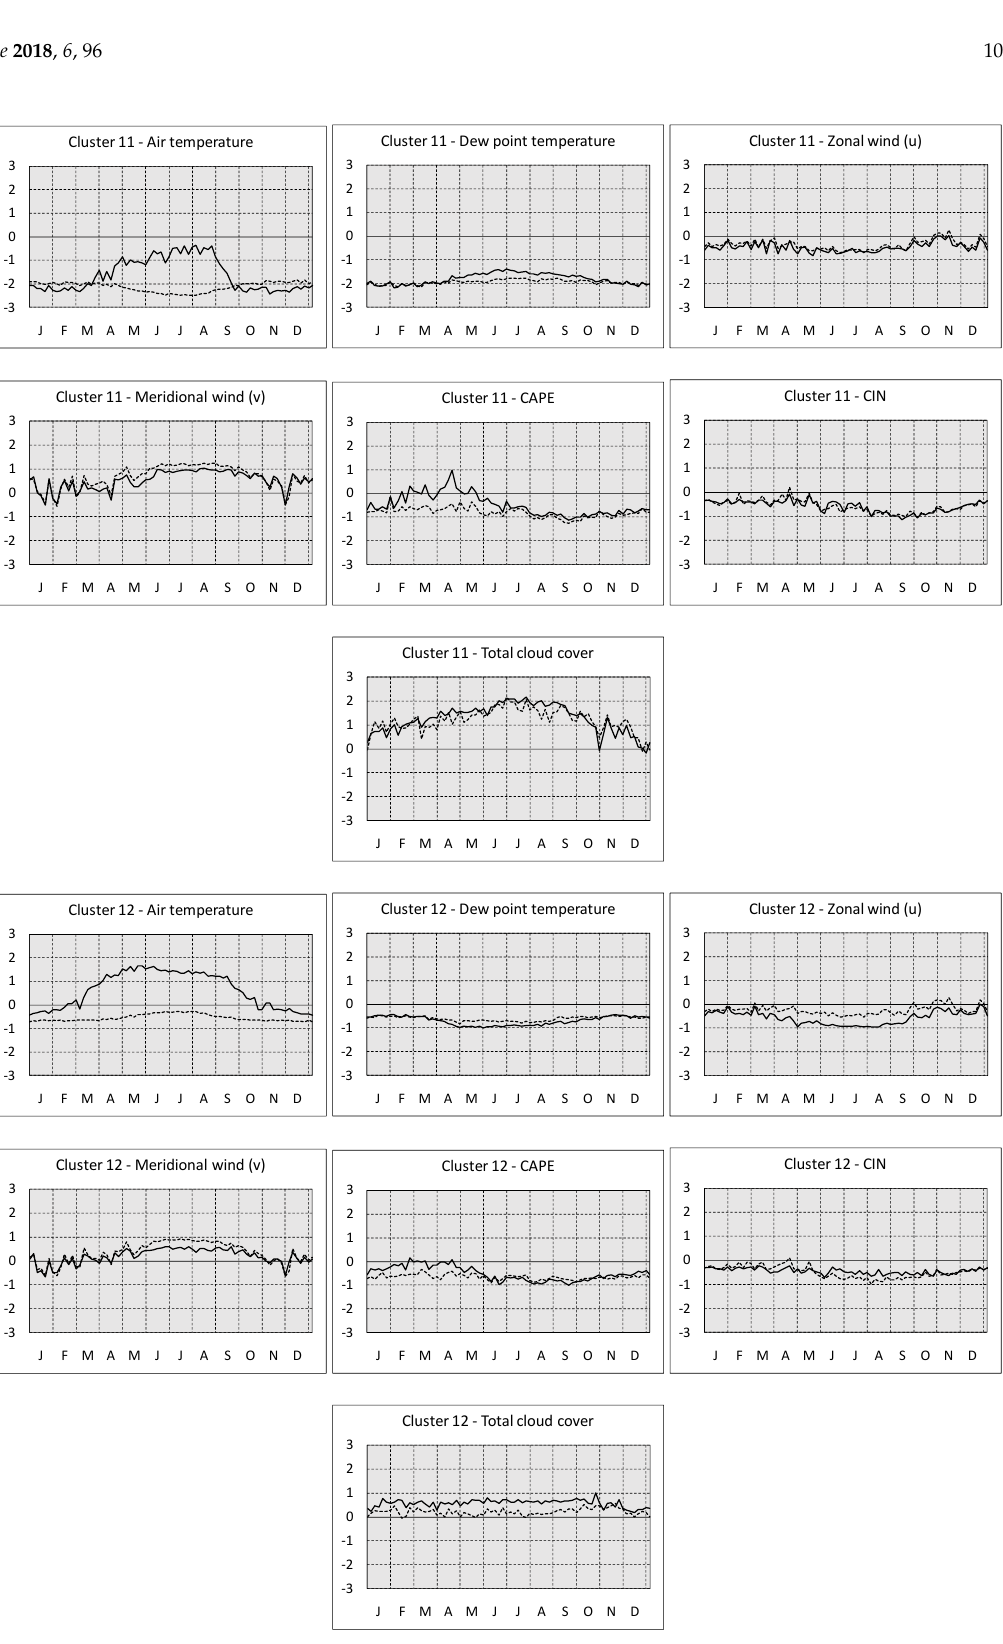
Figure 9. As in Figure 4, but for clusters 11 and 12.